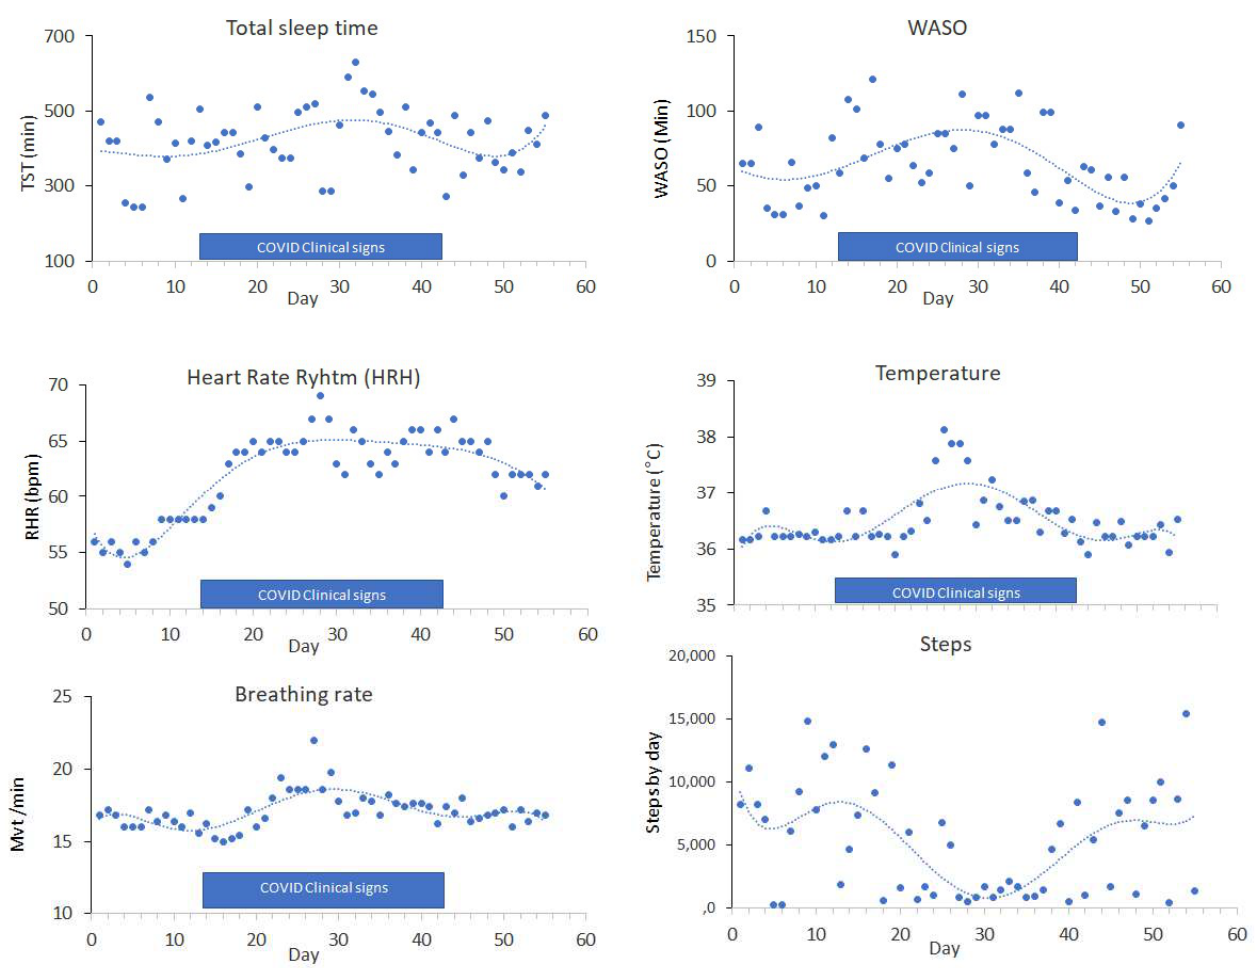
Figure 1. Nocturnal total sleep time, skin temperature, heart rate, breathing, and steps before, during, and after SARS-CoV-2 active disease.